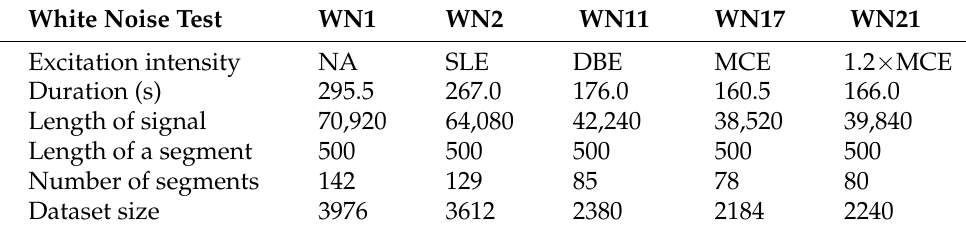
Figure 4. White noise data of sensor 1-101: ( a ) WN1; and ( b ) WN21. Table 1. Summary of